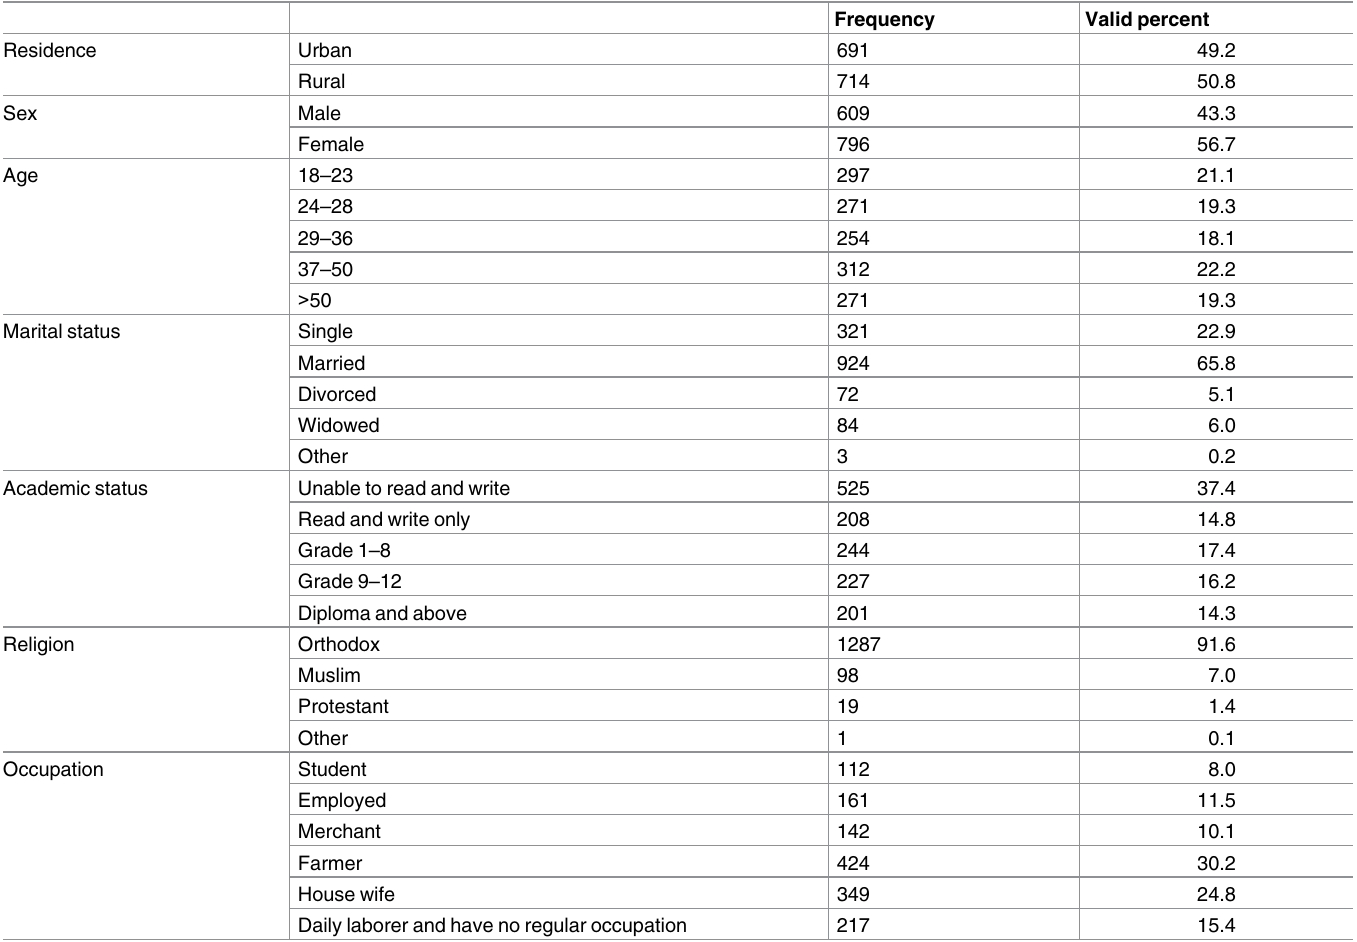
Table 1. Sociodemographic characteristics of study participants (N =